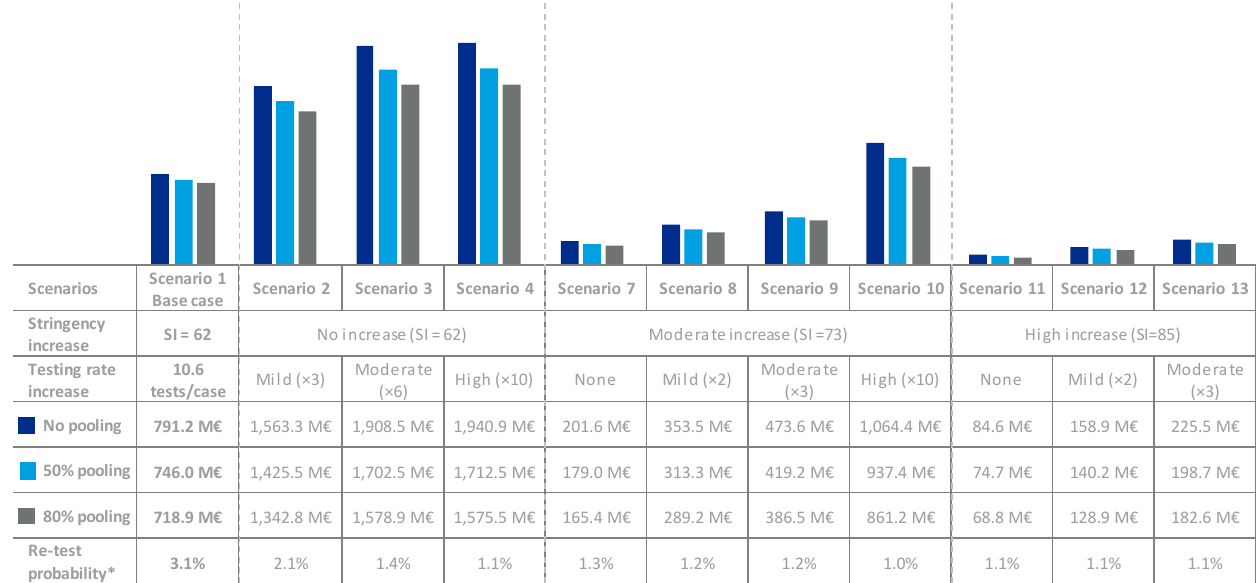
Figure 5. Pooling Efficiency . * Thousand tests and thousand individuals tested. ** Thousand tests. 3.2.1. Potential Impact of NPI on GDP Results from the regression model indicated that lower positivity rates (higher test- ing rate), lower case fatality rate, higher GDP industry share, and lower Stringency Index correlated with lower GDP decline during Q2 2020 (Table S4 and Figure S3). When applying the coefficients for stringency and testing rates to the different sce- narios, a difference of up to 4.4% points is observed for Q4 2020 GDP (Figure 6). For in- stance, scenario 4 (high testing rate increase with no stringency increase) is associated with a 8.9% drop in GDP, 1.9% points lower than our base case (scenario 1), whereas scenarios